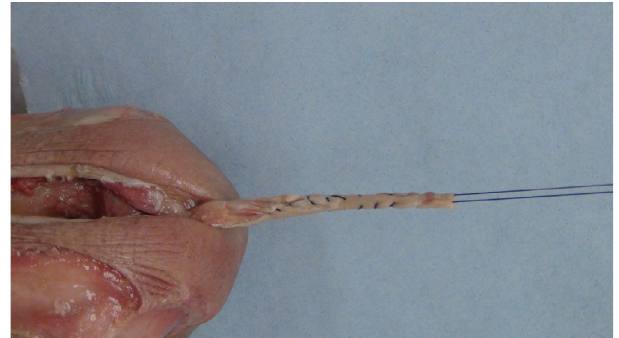
Figure 4. Drilling of the graft tunnel in the ulna through the olecranon fossa.